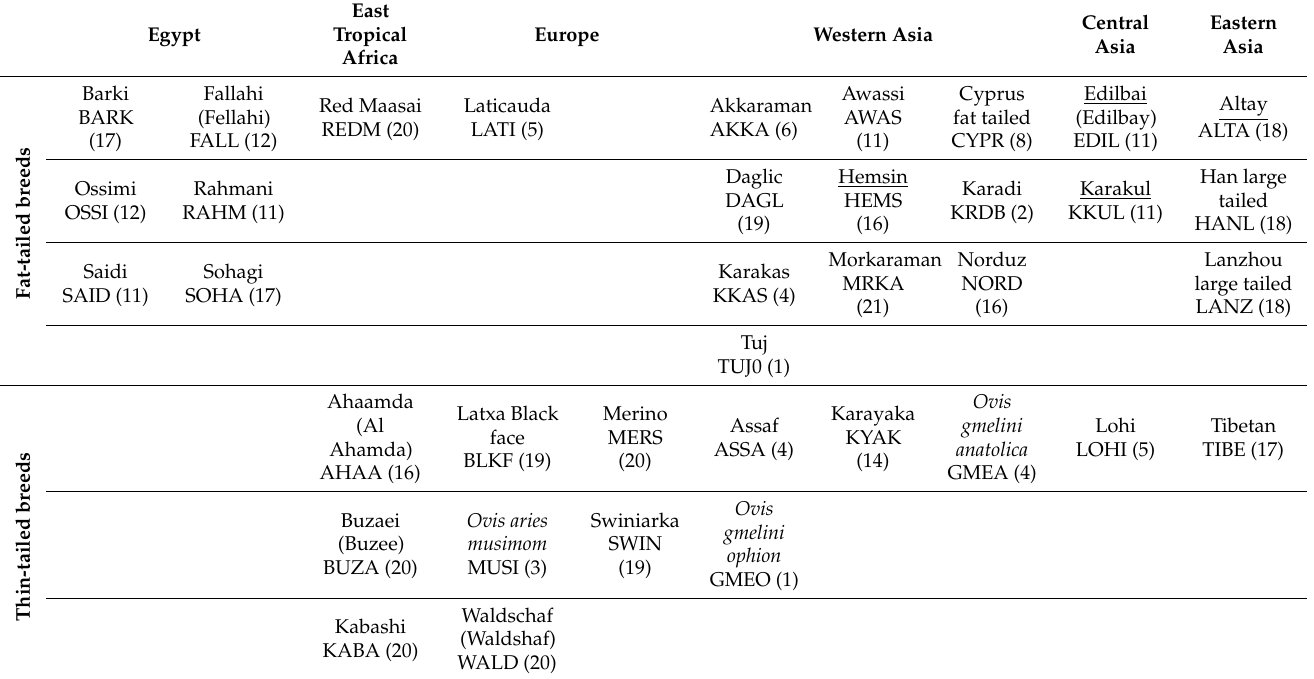
Table 1. Domestic and wild Ovis populations of the database. The underlined characters correspond to fat-rumped breeds. The double-underlined Hemsin means a deposit of fat limited to the base of the tail. The population sizes in the present work and alternative spellings are indicated in brackets. The abbreviations used in the following are designed by a 4-letter code in upper case. The localization of the different populations was synthetized in Supplementary Figure